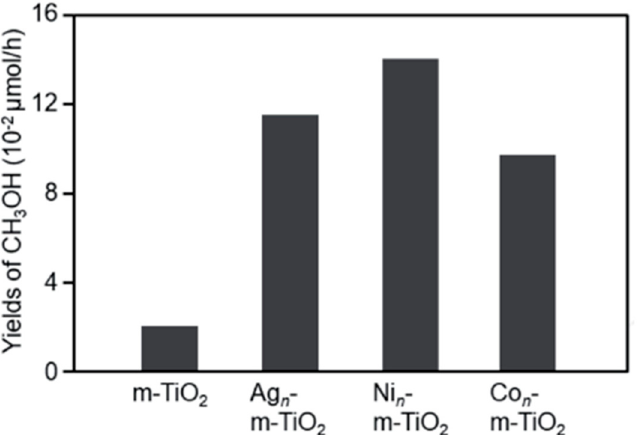
Figure 17. Methanol yield in several doped m-TiO 2 [25]. Reproduced with permission from Negishi et al. Copyright © 2022 ASM